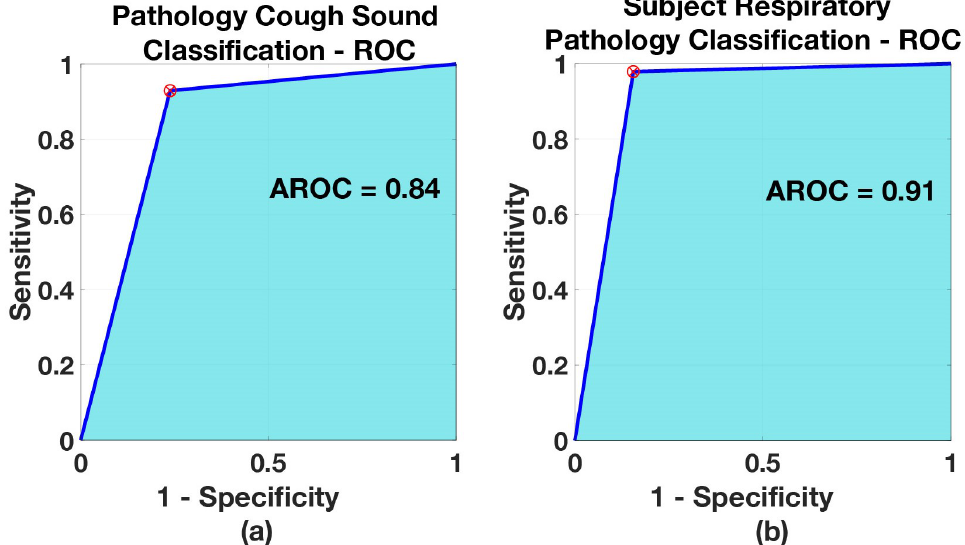
Figure 7. ROC of Model Healthy vs. pathology : ( a ) when classifying coughs, ( b ) when classifying subject for respiratory